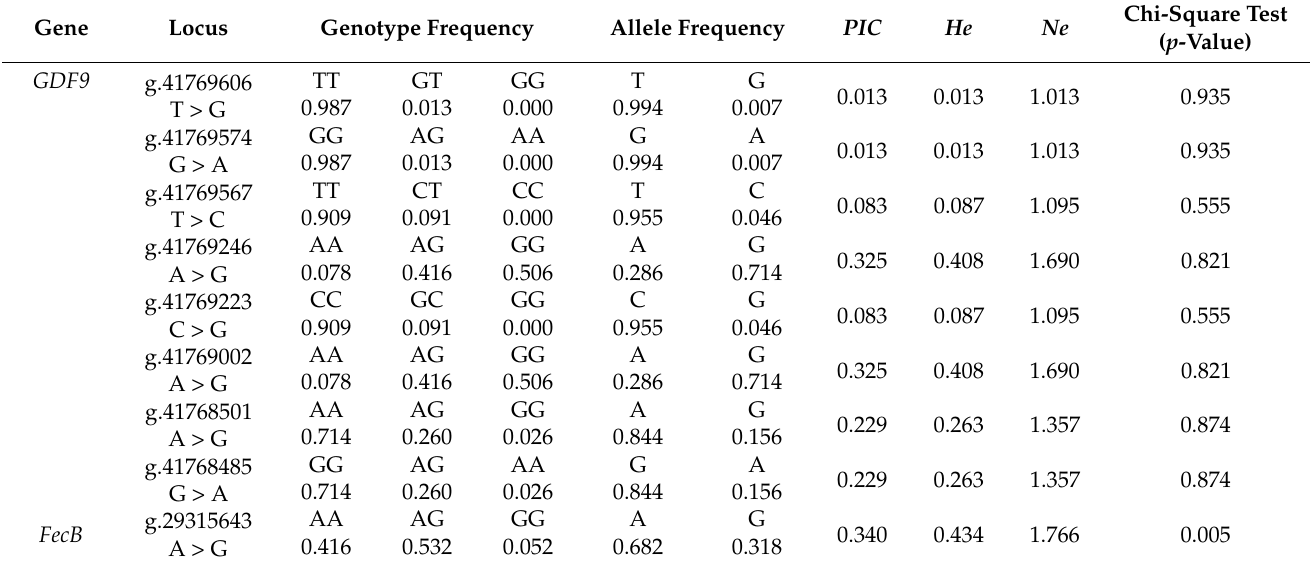
Table 3. Population genetic analysis of eight SNPs for GDF9 and FecB mutations in Luzhong mutton sheep. Gene Locus